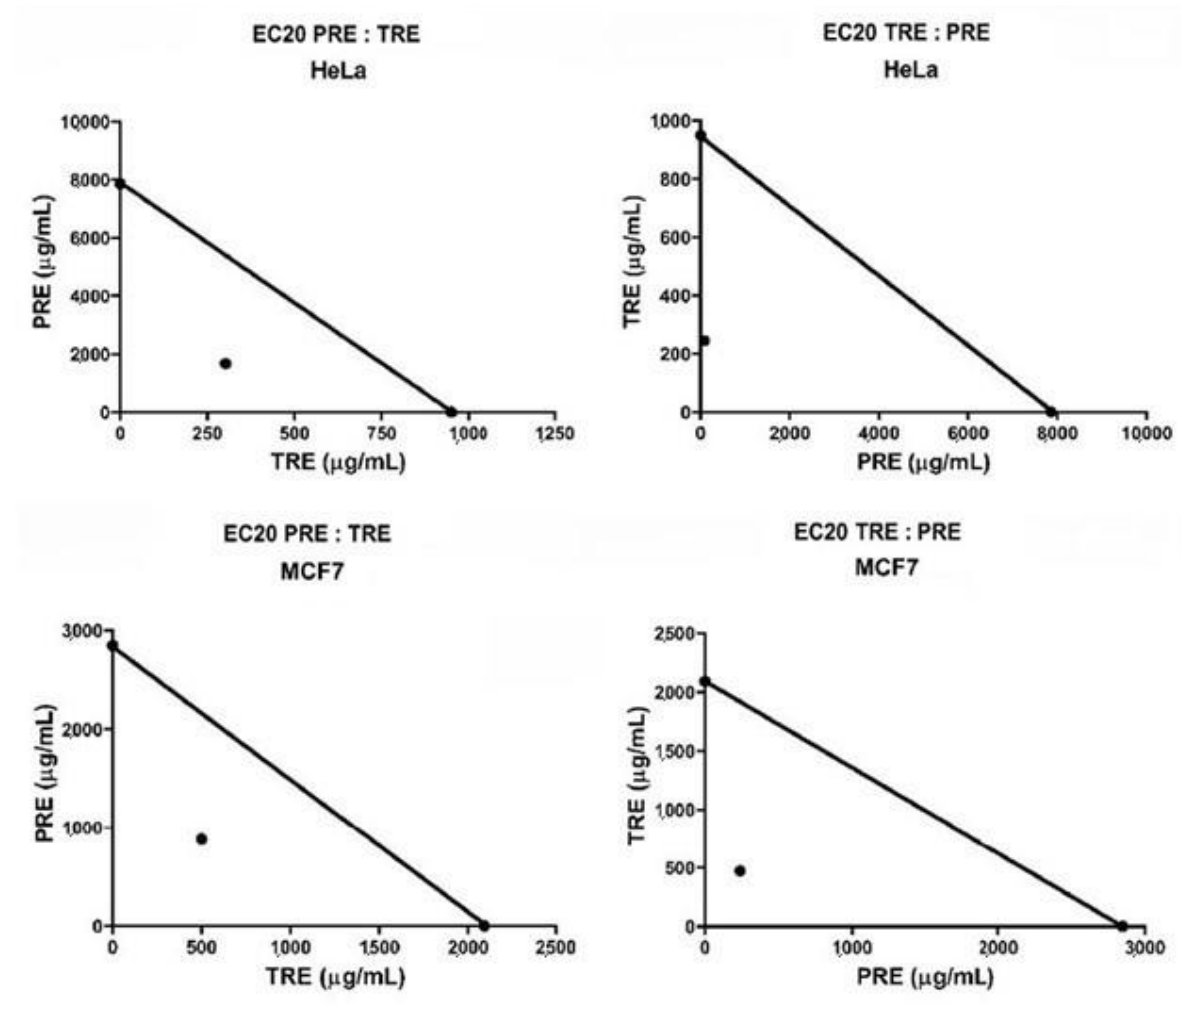
Figure 5. Isobologram of EC20PRE: TRE ( left ) and EC20TRE: PRE ( Right ) from EOA in HeLa ( up ) and MCF7 cells ( down ).